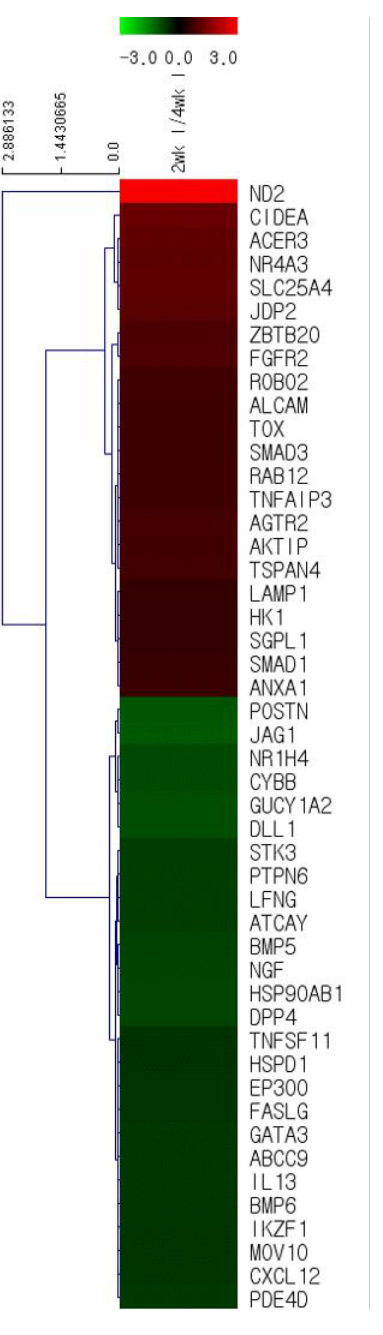
Figure 4. Heat maps and the fold change of differentially expressed genes in the lung of infected ducks. Total RNA was collected from one gram of lung tissue from ducks used for viral titration. The purified RNA was used for microarray using a chicken DNA chip: The differentially expressed genes in the lungs of a 2-week-old duck compared to those in the lungs of a 4-week-old duck. We performed the quantitative real-time PCR in mRNA genes expressed over 2-fold in the lungs of 2-week-old ducks and in the lungs of 4-week-old ducks. The fold increase of NR4AS, CIDEA, and ND2 genes in the lungs of infected 2-week-old ducks than in the lungs of infected 4-week-old ducks were 4.1, 3.5, and 43.7, respectively (Figure 5).